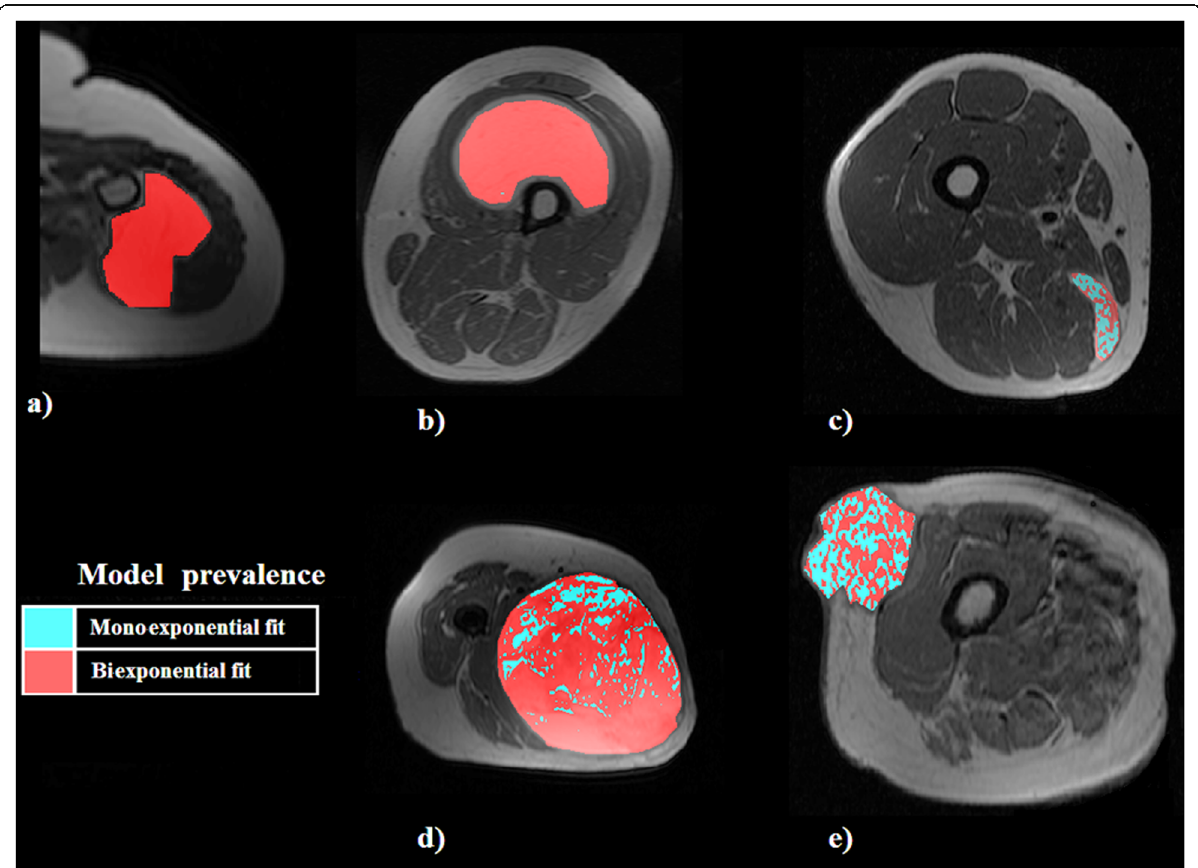
Fig. 7 Voxelwise model classification from Mexp for five patients with different histopathologically proven lipomatous neoplasms: benign lipoma ( a ), well-differentiated liposarcoma ( b ), myxoid liposarcoma ( c ), poorly differentiated liposarcoma ( d ), pleomorphic liposarcoma ( e